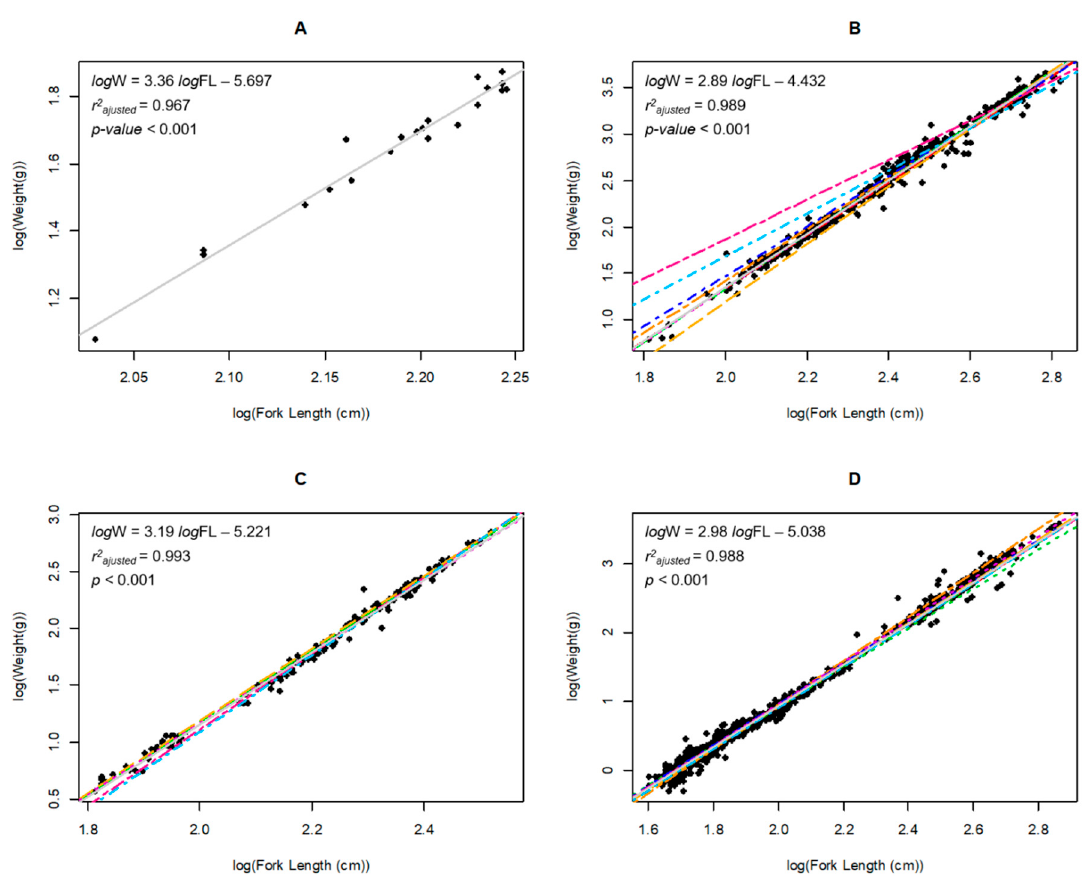
Figure 1. Length–weight relationships (LWR) for ( A ) Alburnus alburnus (Linnaeus, 1758), ( B ) Cyprinus carpio Linnaeus, 1758, ( C ) Rutilus rutilus (Linnaeus, 1758), and ( D ) Sander lucioperca (Linnaeus, 1758). In all graphs, the solid gray line is total LWR or regression lines. Dashed lines are annual LWRs for the eight years (2008 in dark-orange two-dashed line; 2009 in lime-green dotted line; 2010 in red dashed line; 2011 in blue dot-dashed line; 2012 in green long dashed line; 2013 in deep-pink two-dashed line; 2014 in goldenrod long-dashed line; 2015 in magenta dotted line; and 2016 in sky-blue dot-dashed line).